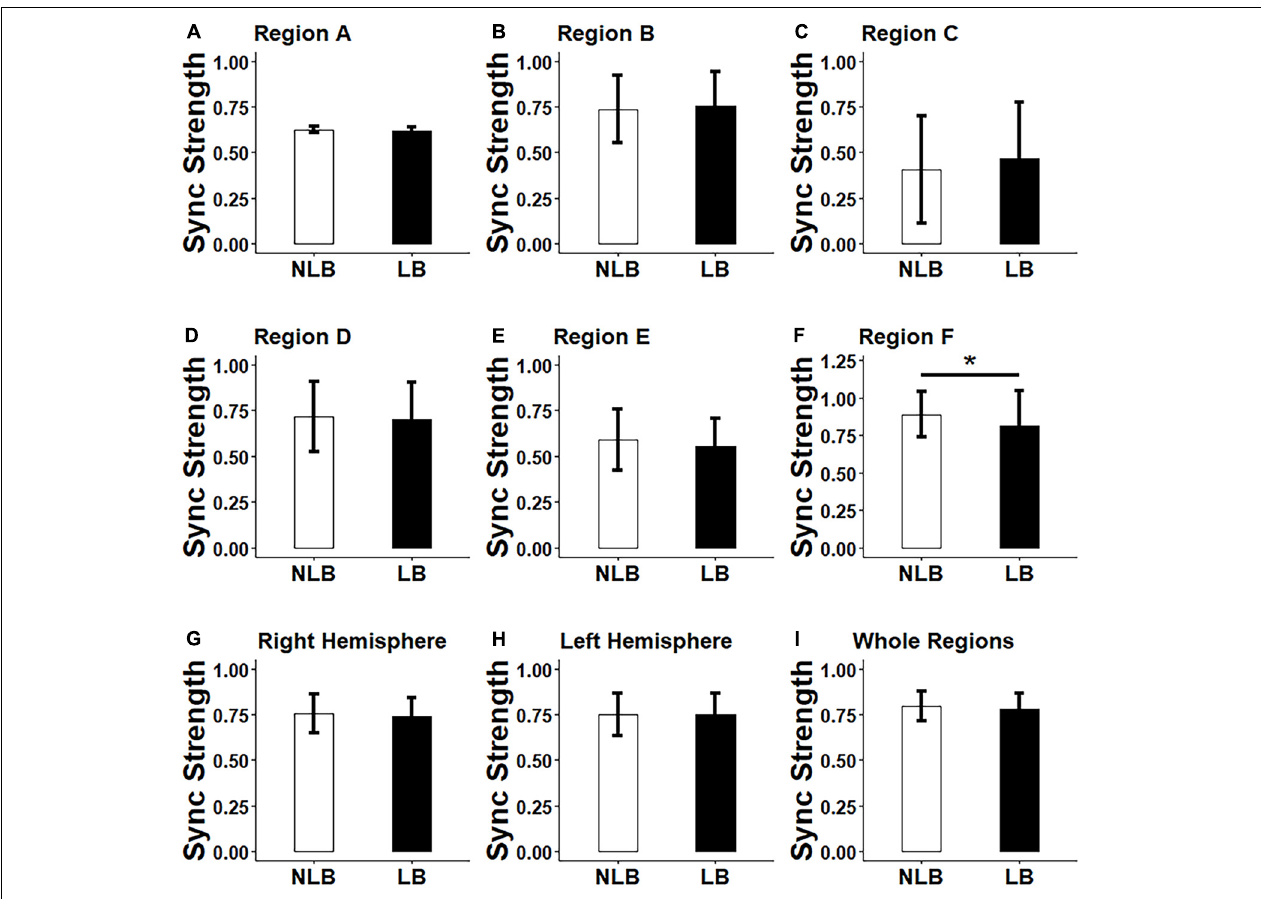
FIGURE 3 | Differences between left-behind and non-left-behind children in synchronization strength of (A–F) : Regions A–F, (G–H) : Right and left hemispheres, and (I) : Whole regions. NLB, non-left-behind; LB, left-behind; Sync, synchronization; * p < 0.05.